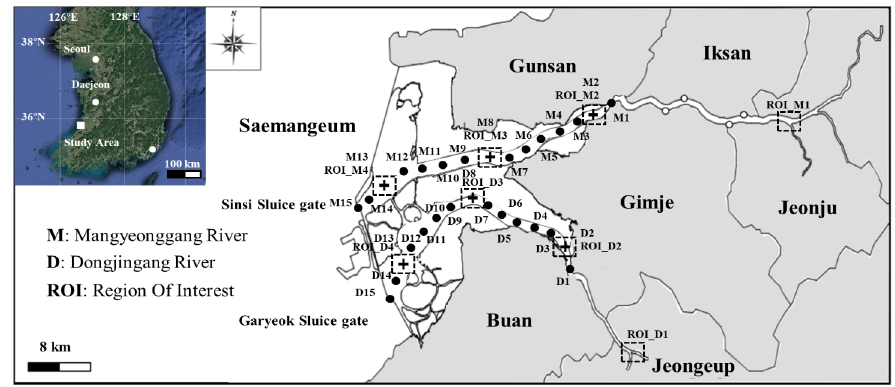
Figure 3. Comparison points between the SCHISM-CoSiNE model and the field measured data (“black o mark”: SCHISM-CoSiNE model results from Dongjingang River to Garyeok drainage gate and from Mangyeonggang River to Sinsi drainage gate, “black + mark”: field measured data by Korean Rural Community Corporation) and regions of interest (“black dashed rectangular mark”: region of interest)